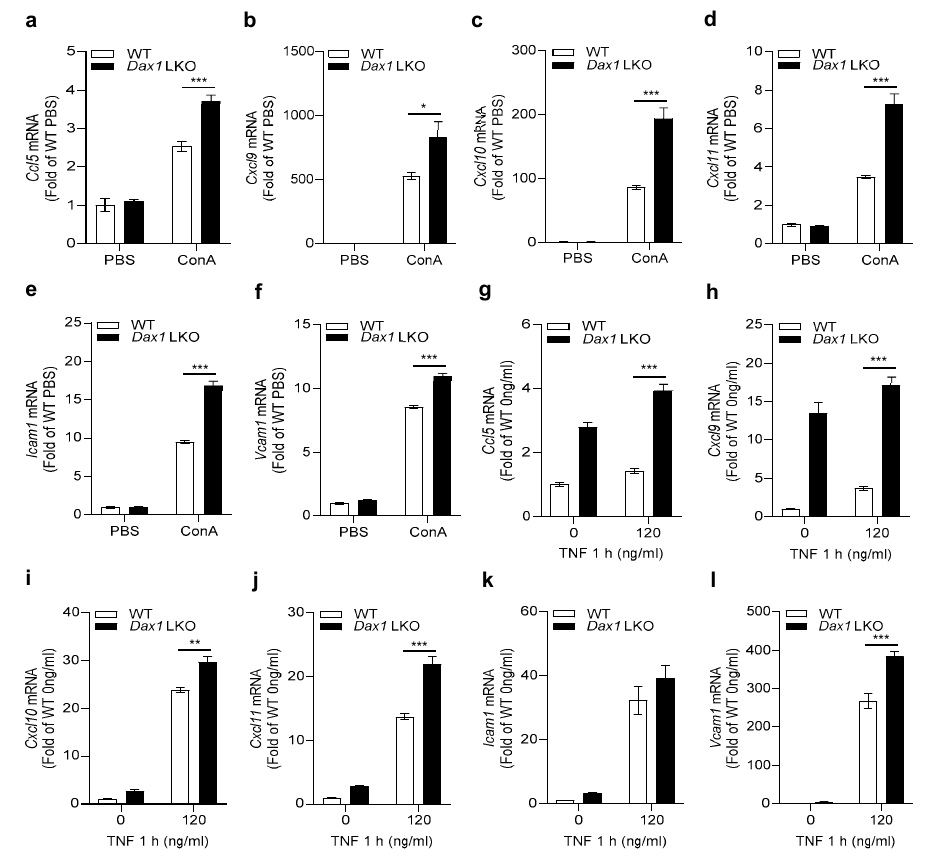
Figure 5. Hepatocyte-specific DAX1 deletion augments expression of chemokines and adhesion molecules related to T lymphocyte recruitment. ( a – f ) WT and Dax1 LKO mice were treated